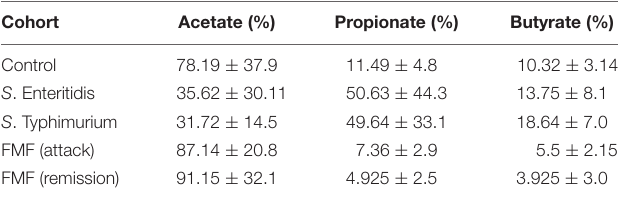
TABLE 1 | Molar ratio of three main systemic SCFAs in salmonellosis and FMF patients.